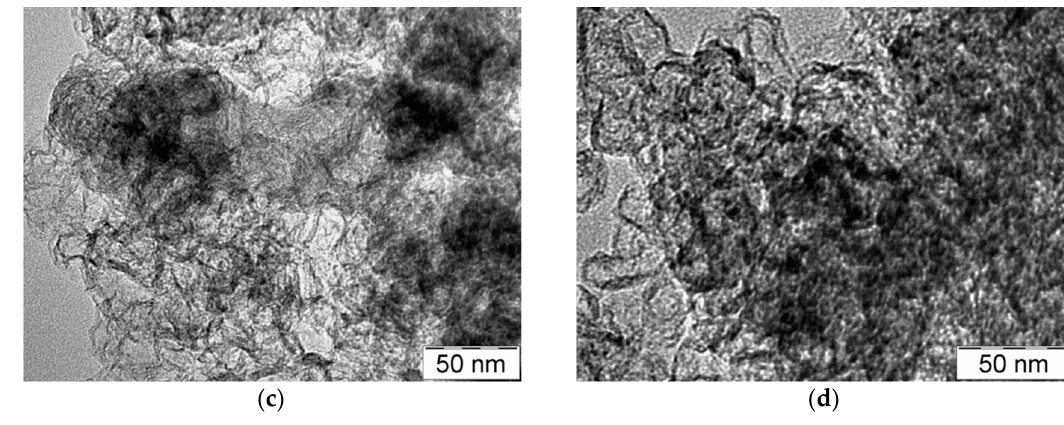
Figure 2. Transmission electron microscopy (TEM) images for the following catalysts: ( a ) CoNC8; ( b ) CoNC10; ( c ) FeNC8; and ( d ) FeNC10.